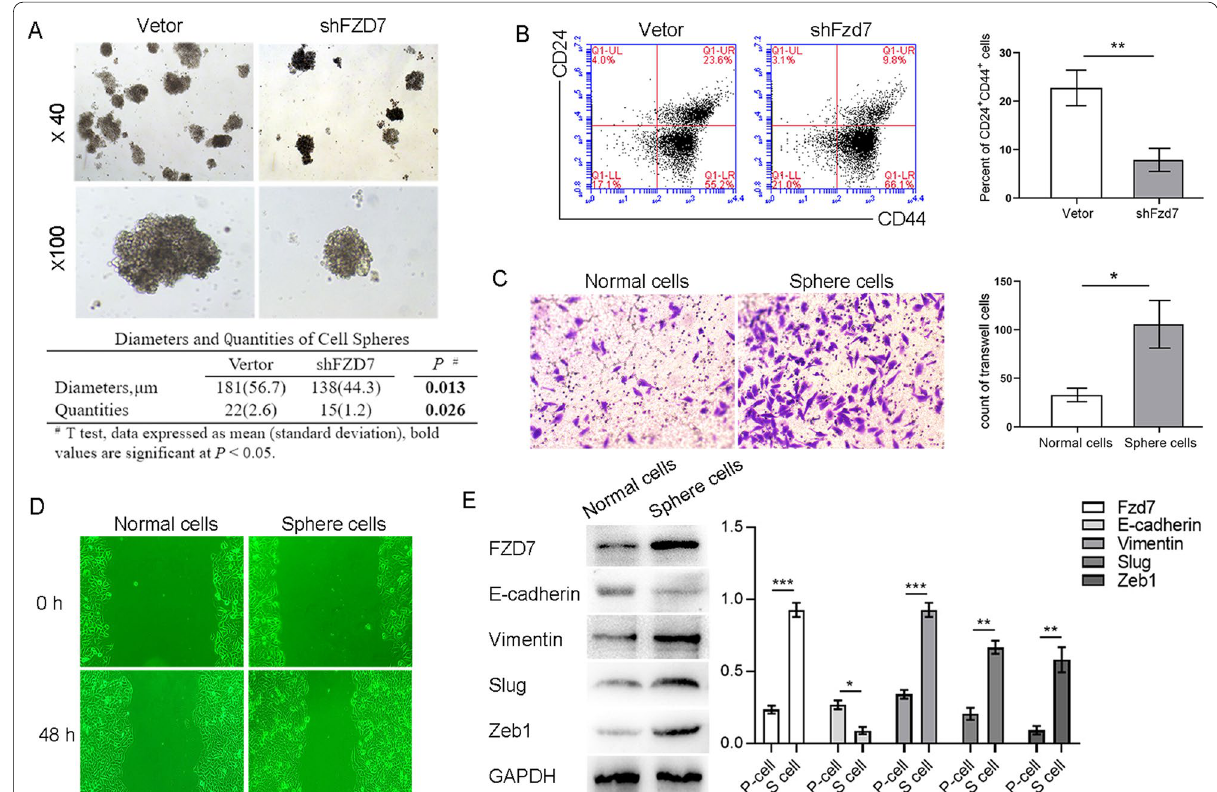
Fig. 4 After silencing FZD7 expression using lentiviral shRNAs, the counts and the diameters of cell spheres were significantly decreased during suspension culture ( A ), and the proportion of CD24 + CD44 + cells in PANC-1 cell line was reduced from 23.6 to 9.8% ( B ). The spheroid-forming cell migration distance was larger than that in normal adherent culture cells ( C ), and the proportion of Transwell cells was higher than that of normal adherent culture cells ( D ). The spheroid-forming cell expressed higher levels of mesenchymal phenotype ( E ). Significant, * P < 0.05, ** P < 0.01, *** P < 0.001, Student’s